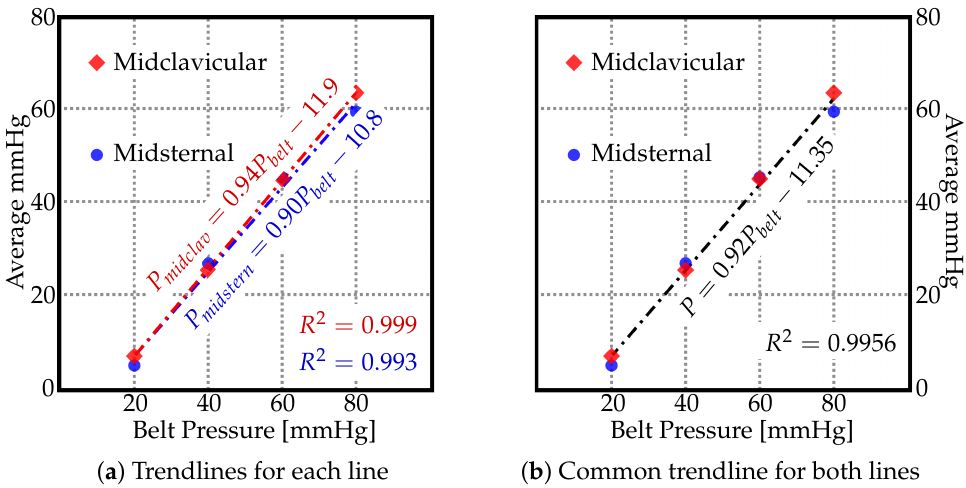
Figure 5. The average pressure values [mmHG] along the midsternal and midclavicular lines for different pressure values to which the belt was inflated ( P belt